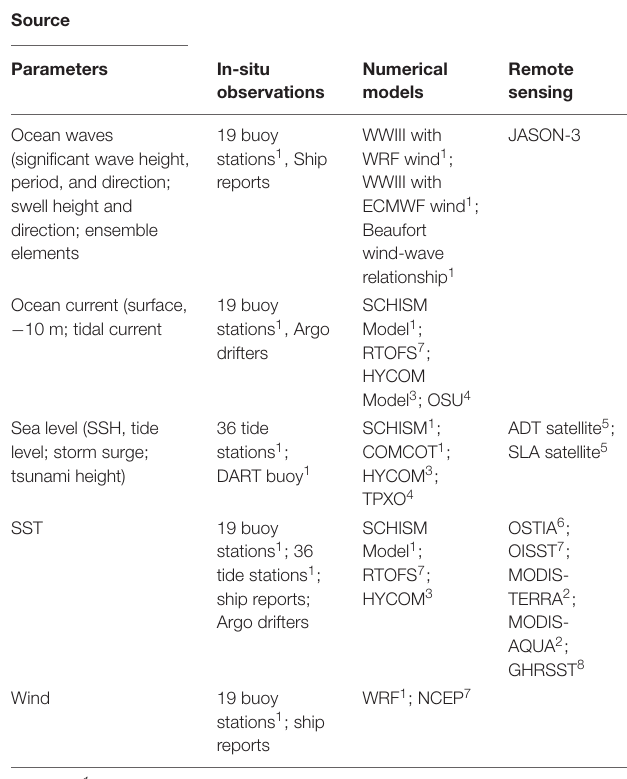
FIGURE 1 | Schematic diagram of the